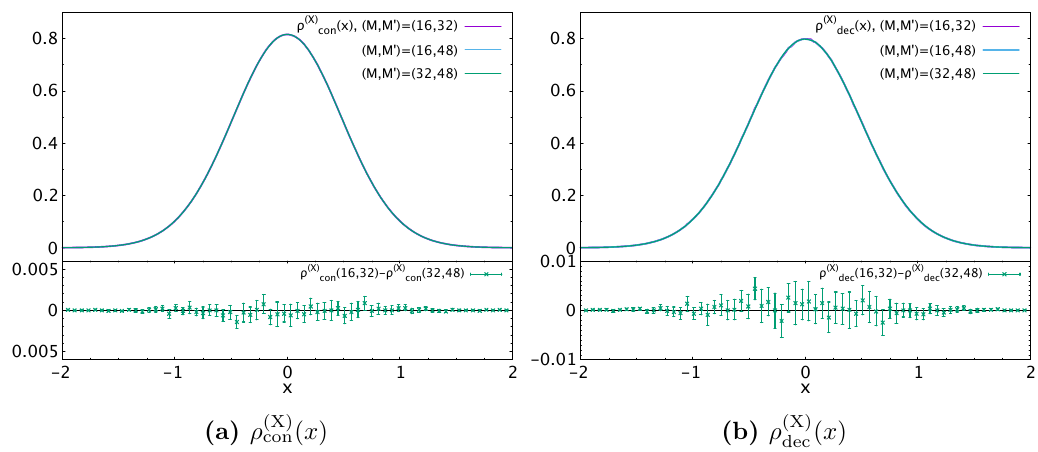
Figure 10. ρ (X) con ( x ) and ρ (X) ( x ) in the Yang-Mills matrix model, N = 64 , L = 24 , and T = 0 . 885 . dec In order to sample M = 16 , 32 and 48 efficiently, we used the trick explained around eq. (4.4). Different combinations of M and M 0 lead to the same result within the error bars. The error bars in each figure are obtained by jackknife analysis.